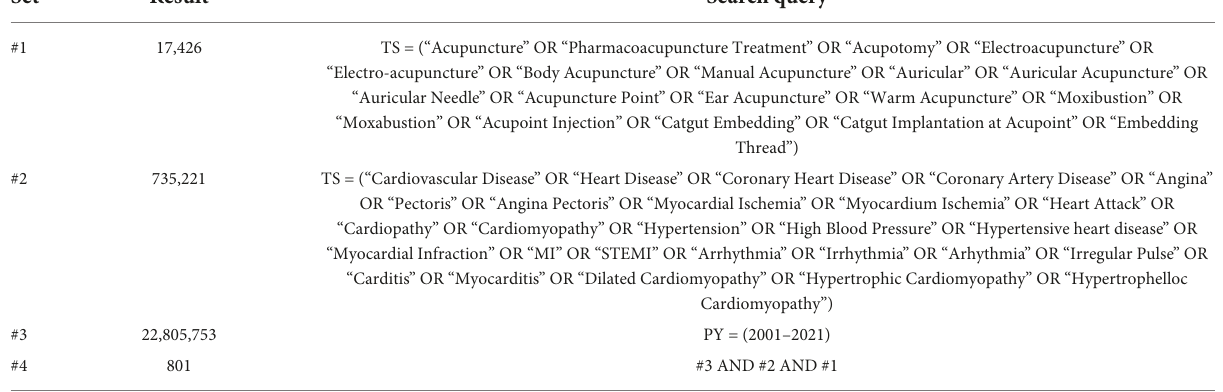
TABLE 1 Search strategy in this